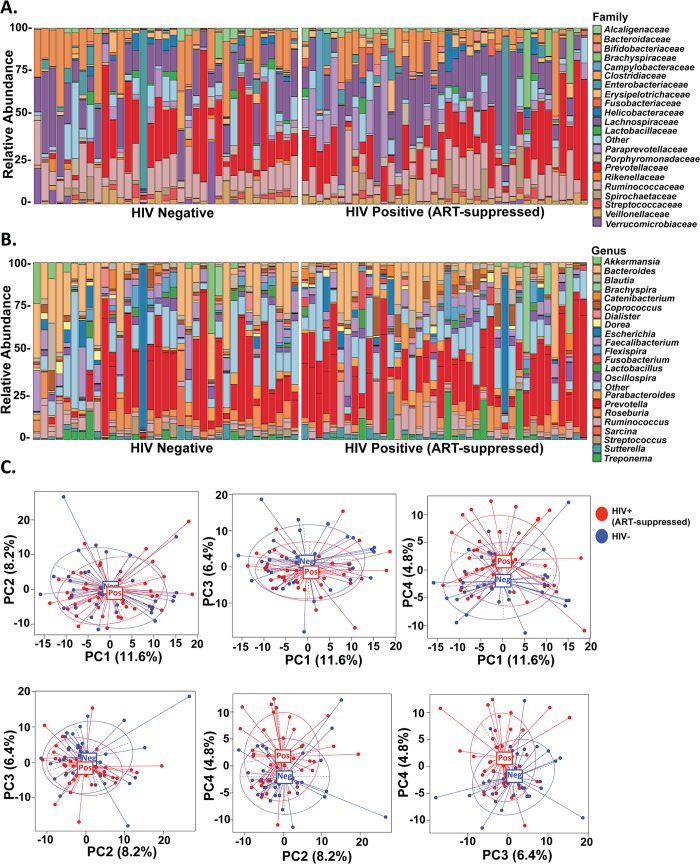
Microbial composition of colorectal biopsies associates with HIV status.Microbial composition was measured by 16S rRNA sequencing from colorectal biopsies obtained from HIV-negative and HIV-positive, ART-suppressed individuals. A.) Relative abundances of the 21 most abundant families with the remaining taxa categorized as “Other”. B.) Relative abundance of the 22 most abundant genera with the remaining taxa categorized as “Other”. C.) Principal component plots visualizing differences in microbial composition between HIV-negative and HIV-positive, ART-suppressed individuals following adjustment for age, race, sex, and sexual orientation.